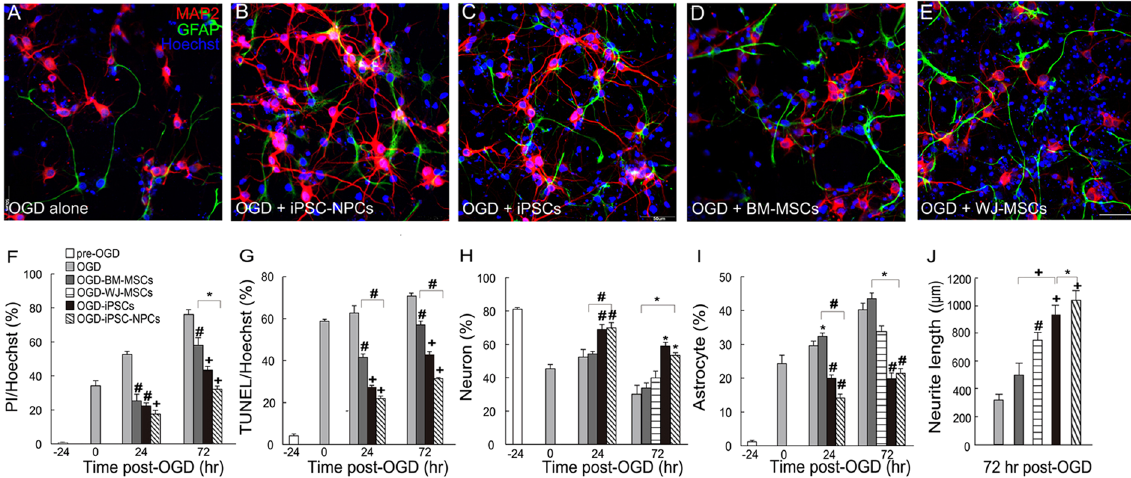
Figure 4. Preferential neuroprotection after oxygen-glucose deprivation (OGD) injury by co-culture with iPSC-NPCs. ( A ) Immunocytochemistry of the rat primary cortical cells subjected to OGD alone and those with transmembrane co-cultures of human ( B ) iPSC-NPCs, ( C ) iPSCs, ( D ) MSCs from bone marrow (BM-MSCs), and ( E ) umbilical cord Wharton’s jelly (WJ-MSCs) at 72 hours post-OGD. The neuronal marker MAP2 is red; the astroglial marker GFAP is green; Hoechst nuclear staining is blue. ( F ) Quantification of the percentage of cell death by propidium iodide (PI) staining, ( G ) apoptotic cells by TUNEL assays, ( H ) the percentage of surviving neurons, ( I ) the percentage of surviving astrocytes, and ( J ) total neurite length at different time points post-OGD. Note that the co-cultures with iPSC-NPCs or iPSCs showed markedly reduced cell death and apoptosis and reduced astrogliosis compared to co-cultures with MSCs from different tissue origins. The results are expressed as mean ± SEM. Scale bar ( A – E ) = 50 µ m. * P < 0.05; # P < 0.01; + P <